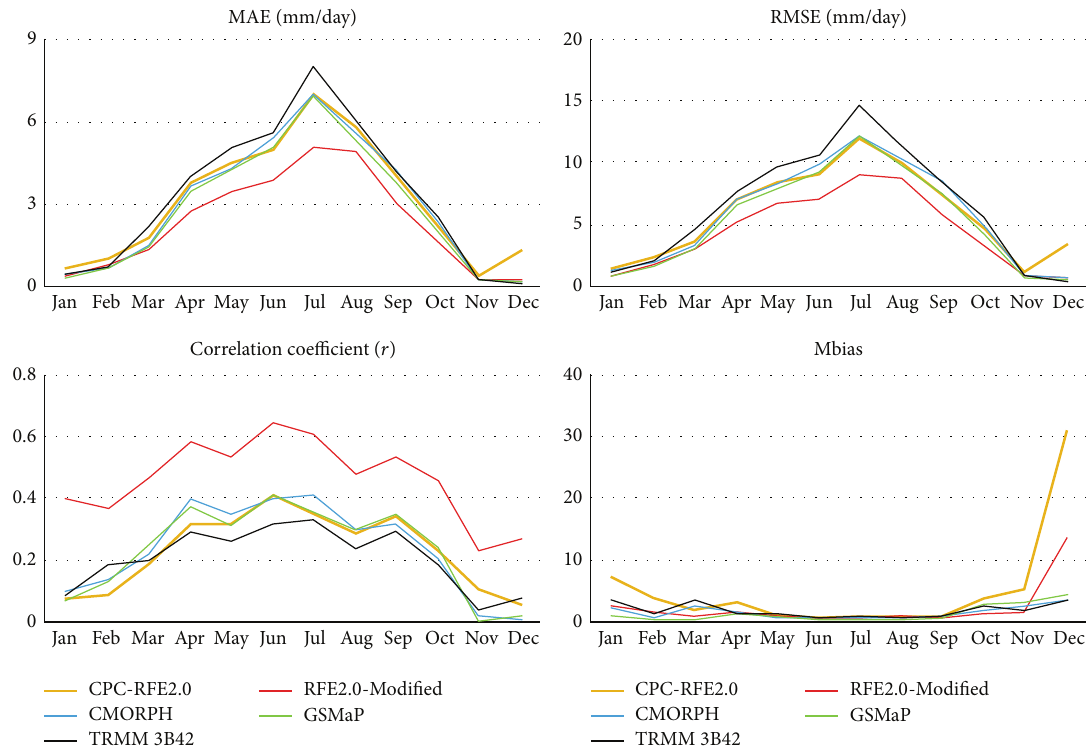
Figure 10: Monthly average of daily error statistics of different satellite products for 2004 to 2006 (C-C analysis).